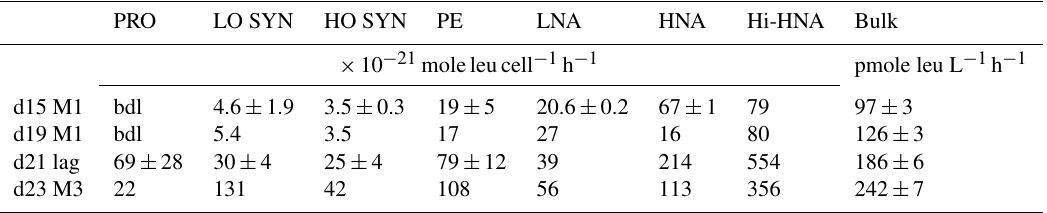
Table 3. Specific leucine activities of main groups sorted: PRO ( Prochlorococcus ), LO-SYN (low orange fluorescence Synechococcus -like cells), HO-SYN (high orange fluorescence Synechococcus -like cells, PE (autotrophic pico-eukaryotes), LNA (low nucleic acid), HNA (high nucleic acid), Hi-HNA (high size and high nucleic acid) heterotrophic bacteria and bulk activities (total community leucine incorporation rates) corresponding to the same sample. When tests of reproducibility have been done, the corresponding data are indicated with their standard deviation. bdl: below detection limits, lag: lagoon waters. PRO LO SYN HO SYN PE LNA HNA